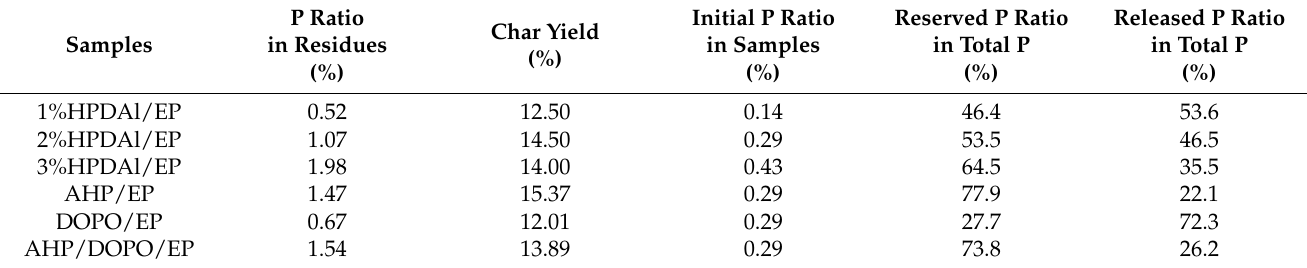
Table 6. Reserved and released P contents in the cone calorimeter test by